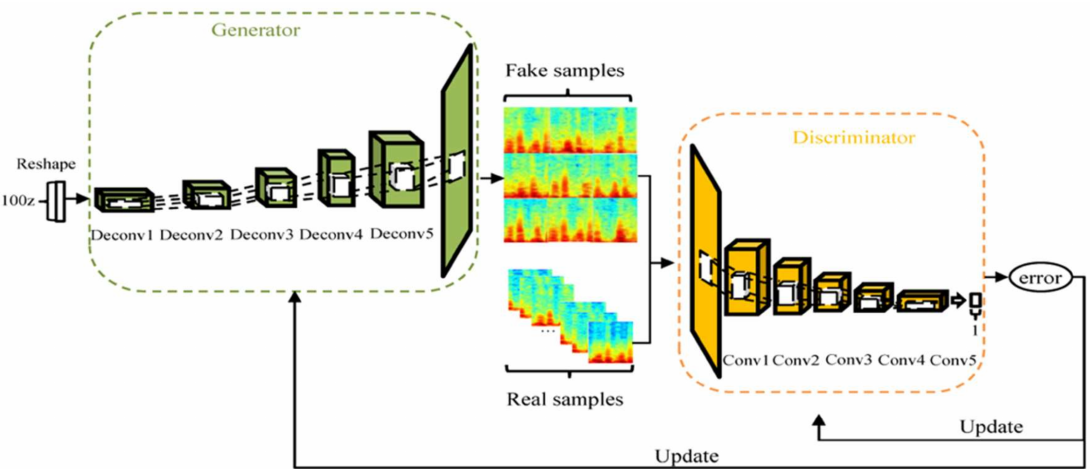
Figure 4. The structure of the DCGAN